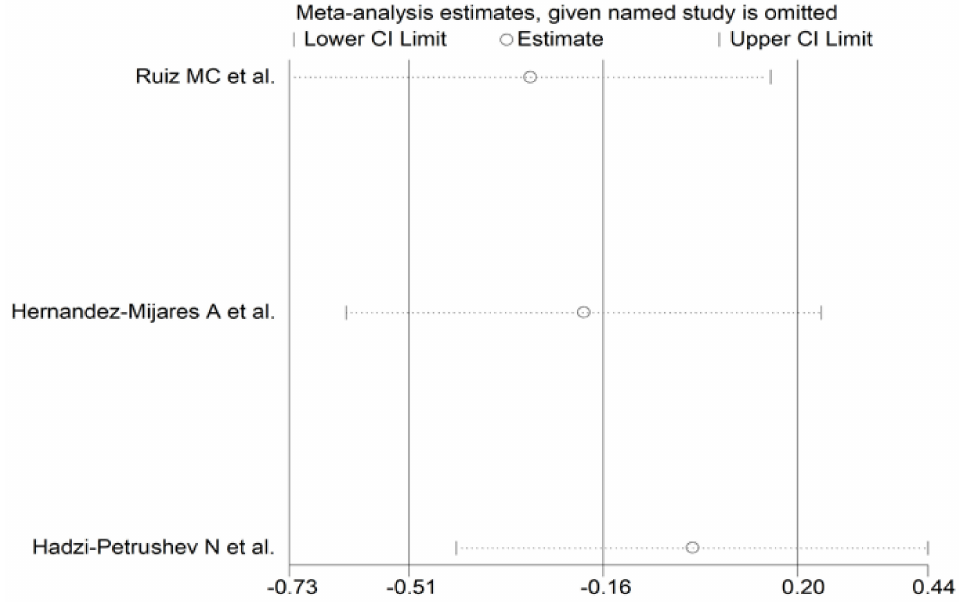
Figure 11. Sensitivity analysis of the influence of each study on the overall standardized mean